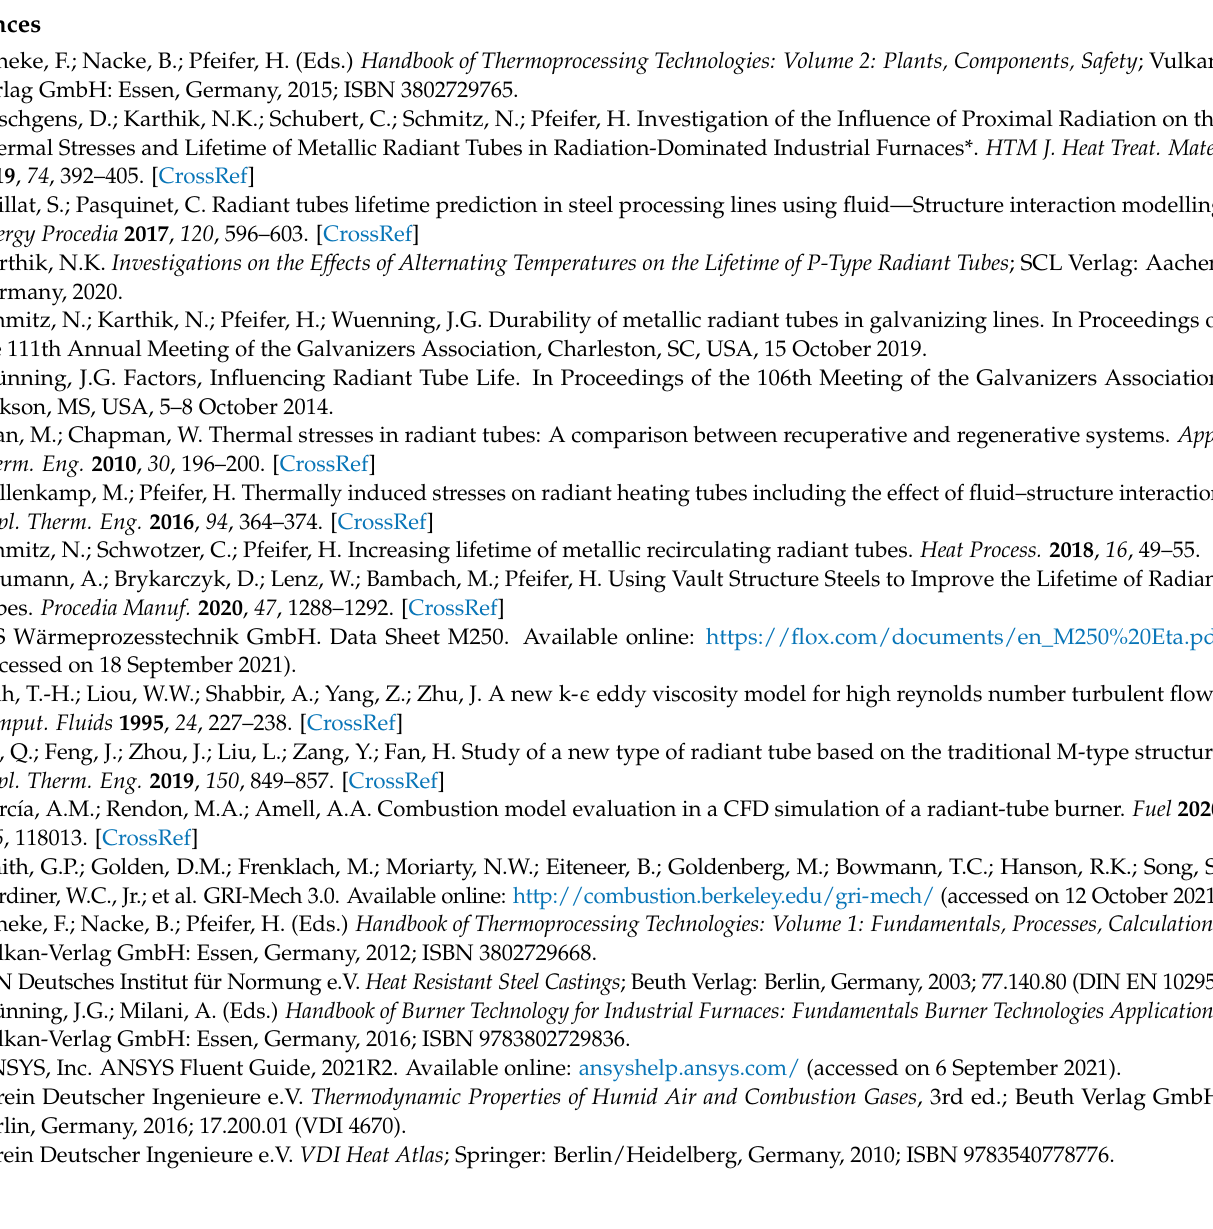
Figure A4. Sampled data points of the dynamic viscosity of air and off-gas at λ = 1.15 calculated in ANSYS ® Fluent in comparison with values from [21].